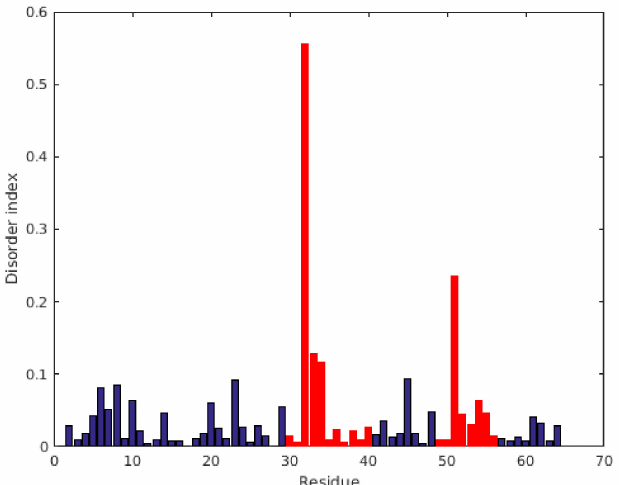
Figure 5. Disorder index (DI), as obtained directly from reduced spectral density mapping of 15 N NMR relaxation data. The DI is just derived from Figure 4 by calculating the geometrical (shortest) distances of the points from the solid (limiting) curve. The γ -core regions are labeled as red bars, while other residues are